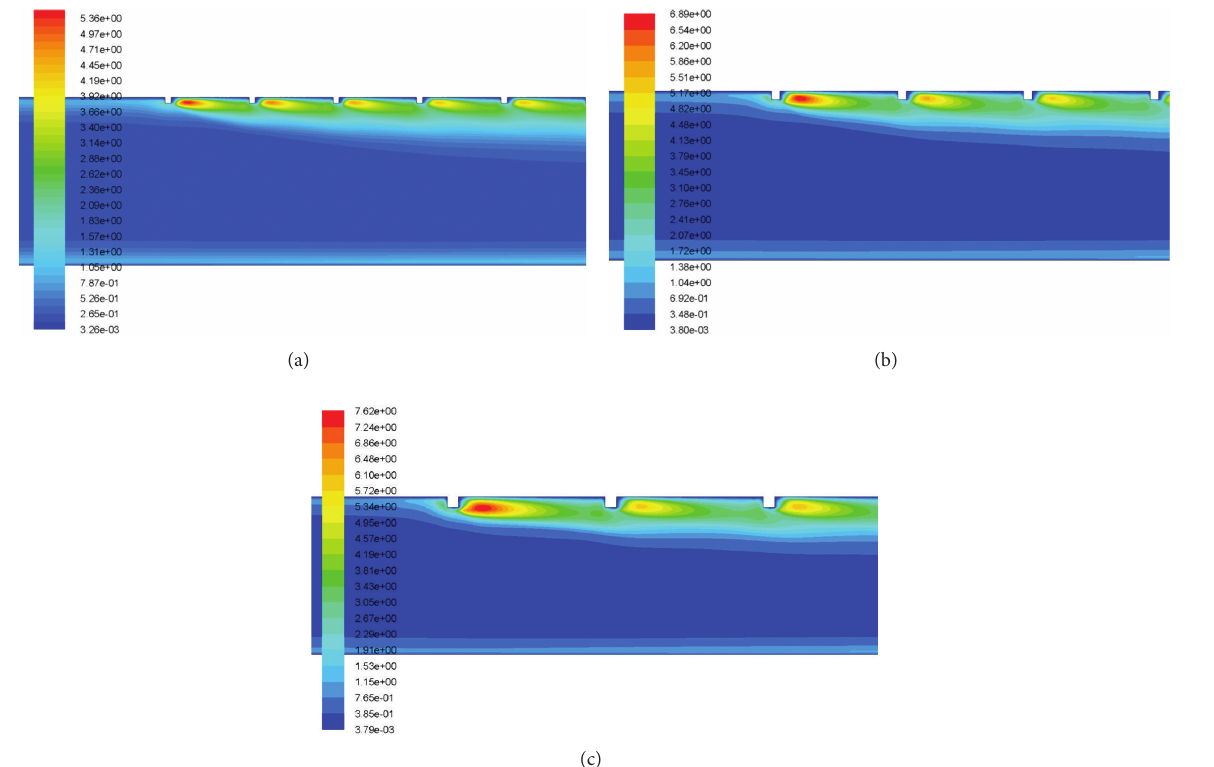
Figure 6: The contour plot of turbulent kinetic energy for Re = 18,000 and 𝑃/𝑒 = 14.29 at a relative roughness height of (a) 𝑒/𝐷 = 0.03 , (b) 𝑒/𝐷 = 0.42 , and (c) 𝑒/𝐷 = 0.06